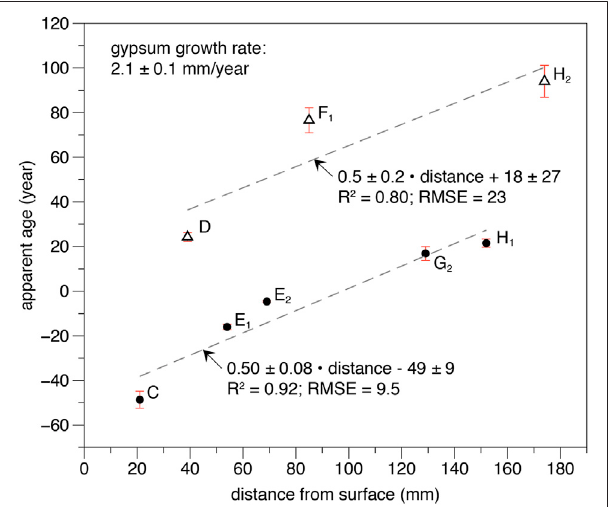
FIGURE 7 | Apparent ages for the gypsum growth zones based on 210 Pb activities corrected for variations in volcanic Rn- fl ux with noble gases. The ages de fi ne two parallel trends with equivalent slopes of 2 mm ofgypsum growthperyear.Thetwotrendsareinterpretedtorepresentgrowthfrom two seepage fl ows. Uncertainties are 1 standard